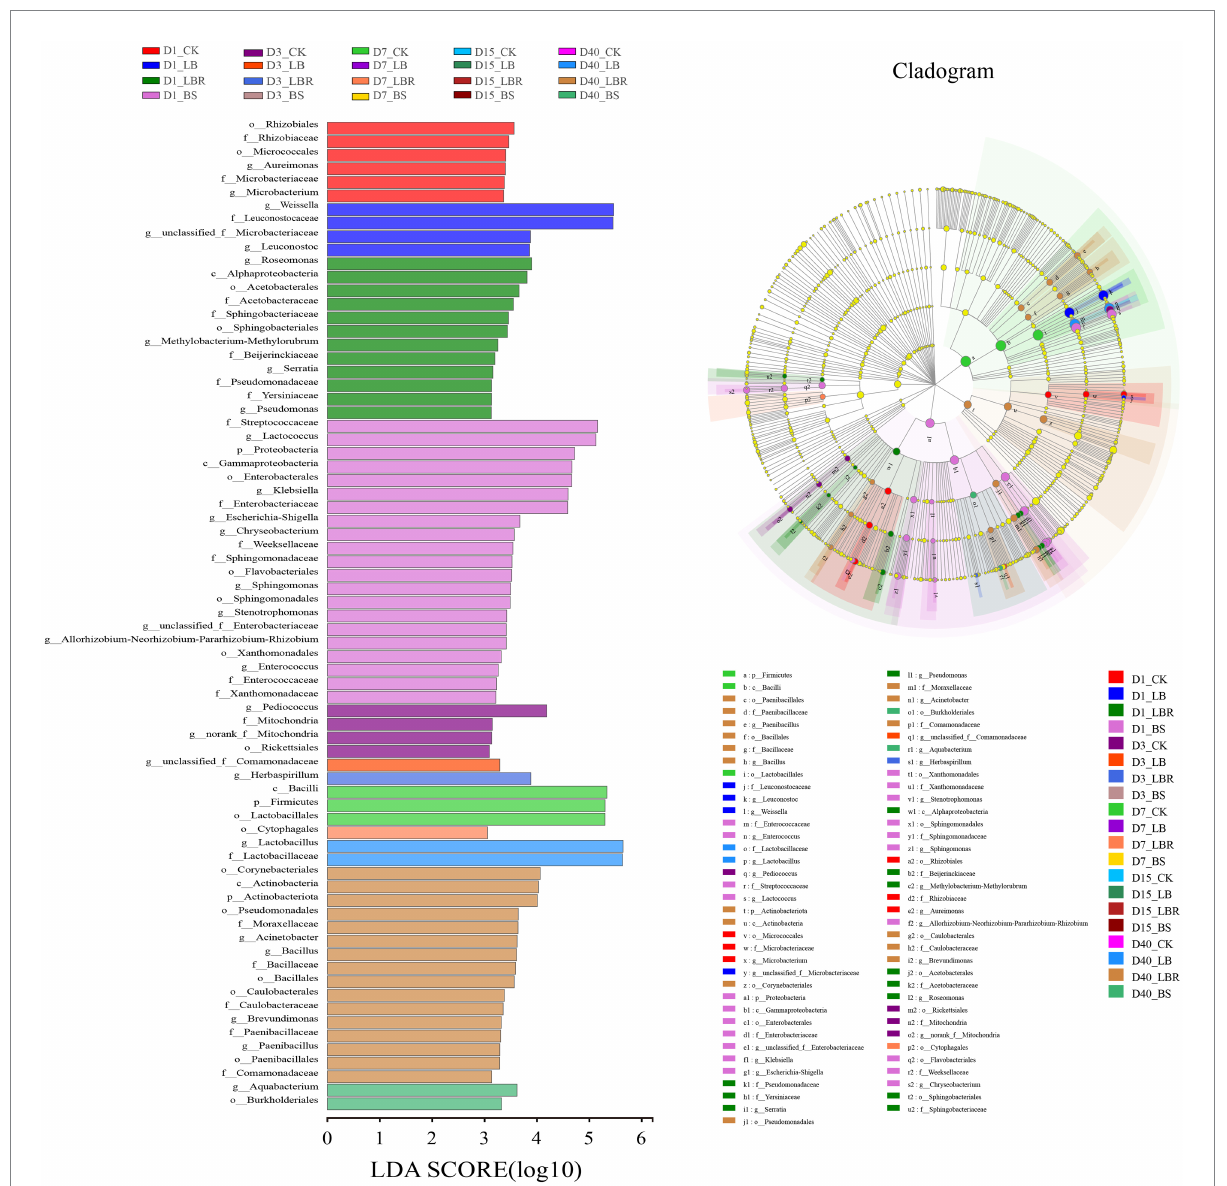
FIGURE 3 Comparison of microbial variations in sorghum-sudangrass after ensiling for 1, 3, 7, 15, and 40 days using the LEfSe online tool (CK, control; LB, Lactobacillus buchneri ; LBR, Lactobacillus brevis; BS, Bacillus subtilis